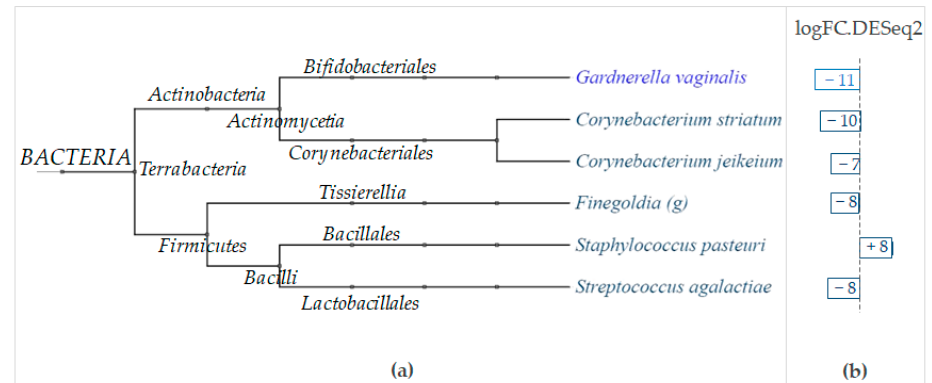
Figure 12. Taxa differentially modulated by the LimpiAL treatment in the microbiota of inguinal Figure 12. Taxa di ff erentially modulated by the LimpiAL treatment in the microbiota of inguinal